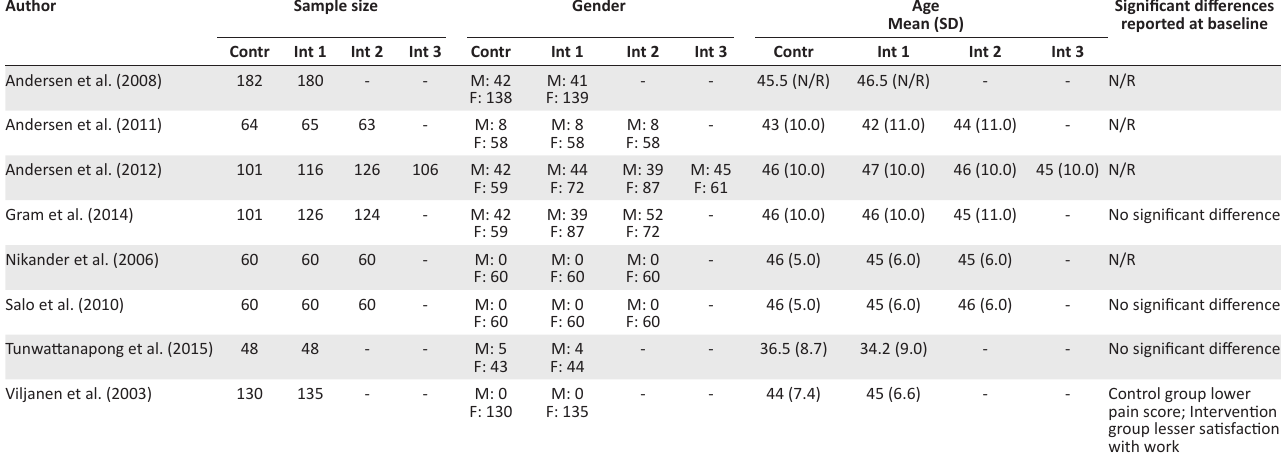
TABLE 2: Study sample